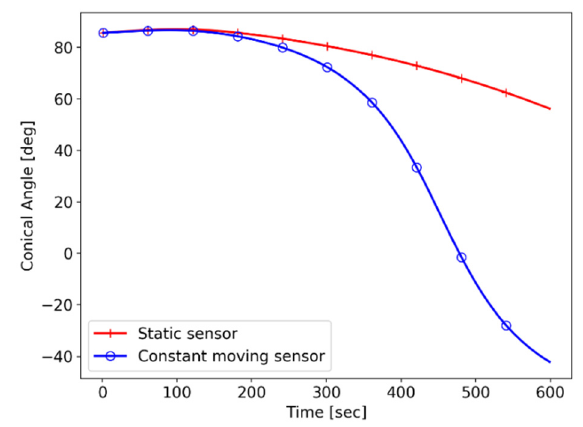
Figure 12. Simulation II: conic angle trajectories.